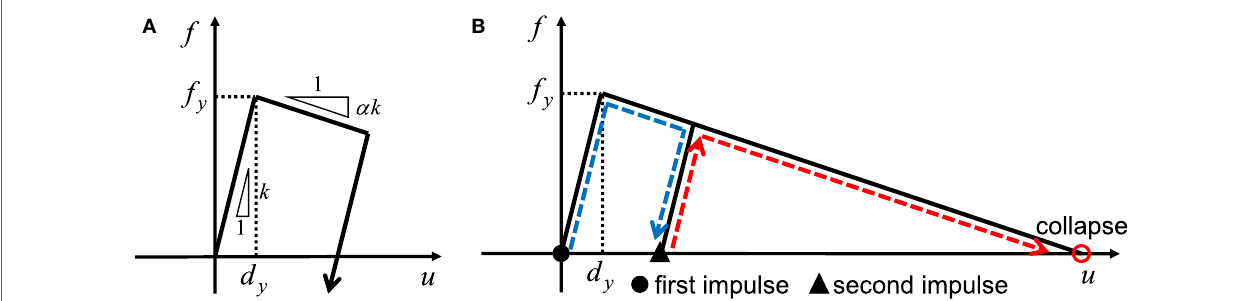
FIGURE 3 | Restoring-force characteristic and collapse scenario: (A) Normal bilinear hysteresis with negative second slope. (B) Collapse scenario under two impulses.